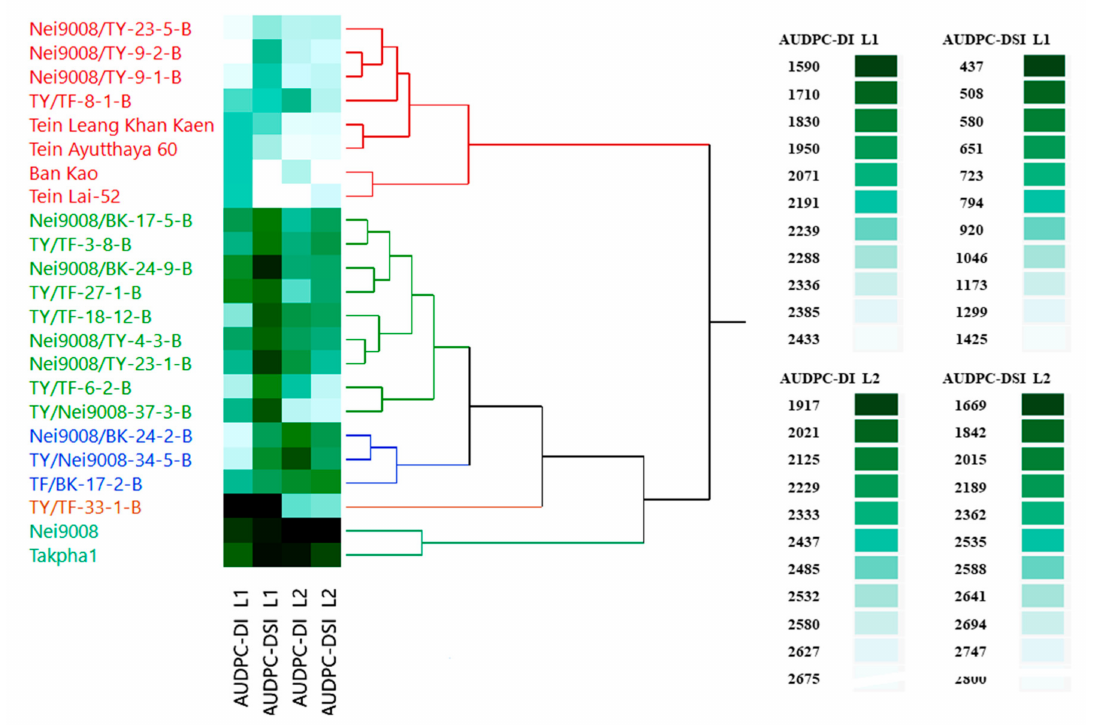
Figure 5. Means of the area under the disease progress curve of disease incidence (AUDPC-DI) and the disease progress curve of disease severity index (AUDPC-DSI) of downy mildew in 23 small-ear waxy corn varieties at Nong Bau Village (L1) and Sok Maung Village (L2) in the rainy season